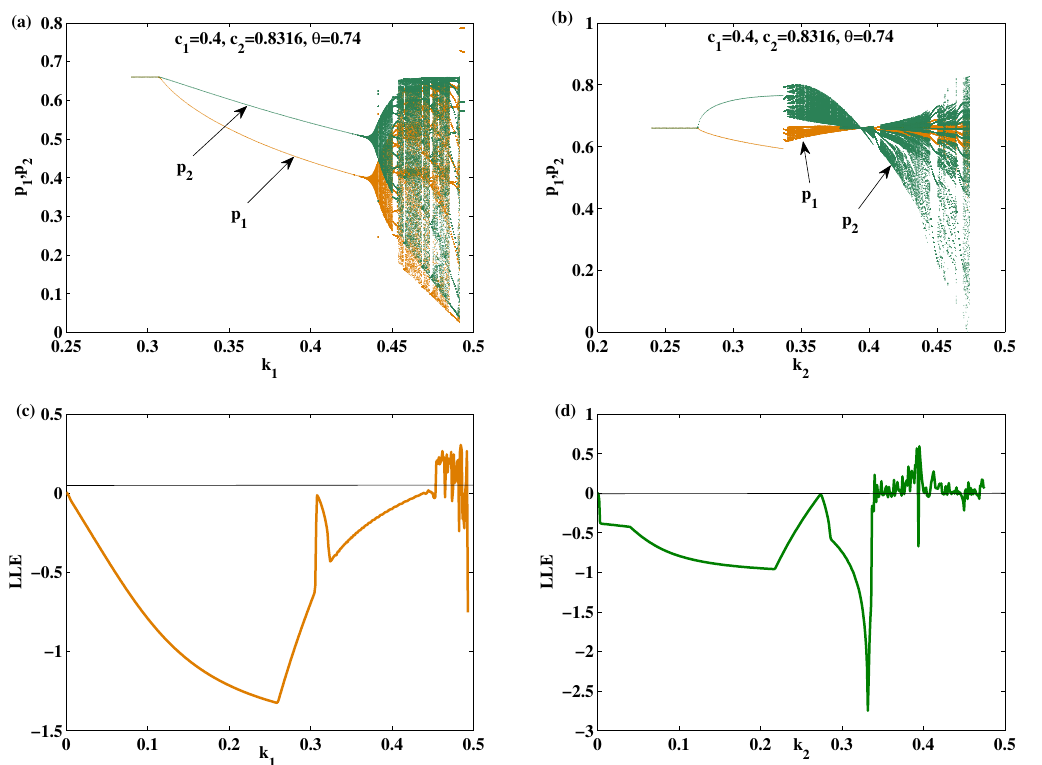
Figure 2. ( a ) Bifurcation diagrams with respect to p 1 and p 2 on varying k 1 at: c 1 = 0.4, c 2 = 0.8316, θ = 0.74 and k 2 = 0.1. ( b ) Bifurcation diagrams with respect to p 1 and p 2 on varying k 2 at: c 1 = 0.4, c 2 = 0.8316, θ = 0.74 and k 1 = 0.1. ( c ) Largest Lyapunov exponent on varying k 1 for c 1 = 0.4, c 2 = 0.8316, θ = 0.74 and k 2 = 0.1 ( d ) Largest Lyapunov exponent on varying k 2 for c 1 = 0.4, c 2 = 0.8316, θ = 0.74 and and k 1 =